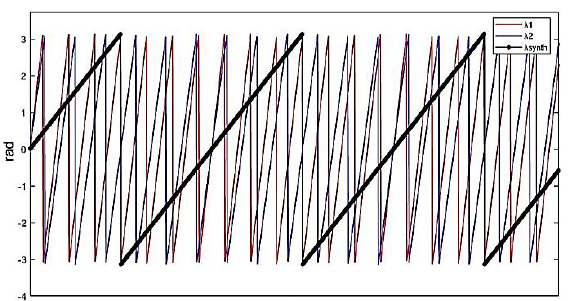
Fig.1. Graphical representation of the difference of the measurement range covered by smaller ( 𝜆 1 , 𝜆 2 ) and larger ( 𝜆 𝑠𝑦𝑛𝑡ℎ ) wavelength.